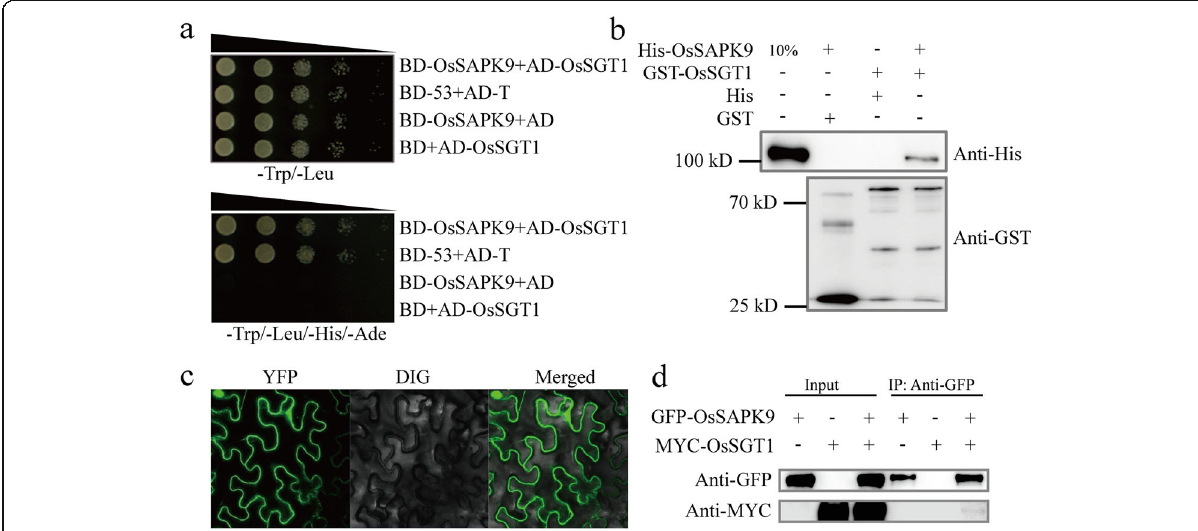
Fig. 3 OsSAPK9 interactions with OsSGT1 in vitro and in vivo. a OsSAPK9 interaction with OsSGT1 in yeast. AH109 yeast transformants diluted 10, 100, 1000, or 10,000 times were plated on synthetic dextrose (SD) medium lacking Trp and Leu amino acids (SD − L/T) or SD medium lacking Trp, Leu, His, and Ade amino acids (SD − L/T/W/A). b OsSAPK9 bound to OsSGT1 in the glutathione S-transferase (GST) pull-down assay. c OsSAPK9 interaction with OsSGT1 in Nicotiana benthamiana cells in the bimolecular fluorescence complementation assay. OsSAPK9 was fused to an N- terminal yellow fluorescent protein (NYFP-OsSAPK9) and OsSGT1 was fused to a C-terminal cyan fluorescent protein (CCFP-OsSGT1). d OsSAPK9 bound to OsSGT1 in the co-immunoprecipitation assay. Constructs encoding green fluorescent protein-tagged OsSAPK9 and Myc-tagged OsSGT1 were co-expressed in Agrobacterium -infiltrated N. benthamiana cells. Tissues were harvested 3 d after